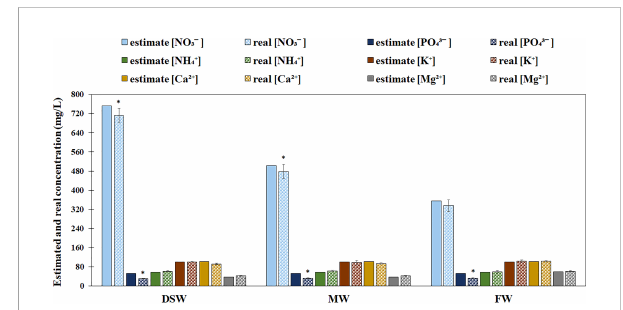
FIGURE 4 Estimated and measured concentrations in trial 6. Asterisks indicate signi fi cant differences ( p ≤ 0.05). The fertilizers KNO3, NH4NO3, H3PO4, Ca(NO 3 ) 2 , and Mg(NO 3 ) 2 were used for the